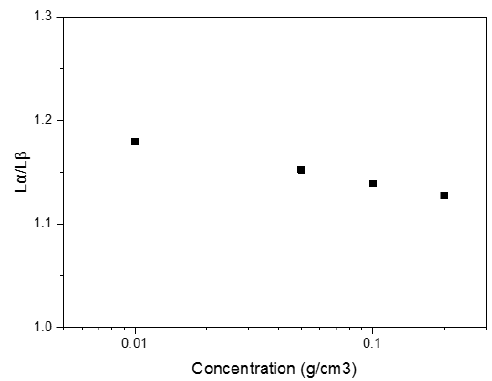
Fig. 3 The peak ratio of L α and L β of lead for each concentration